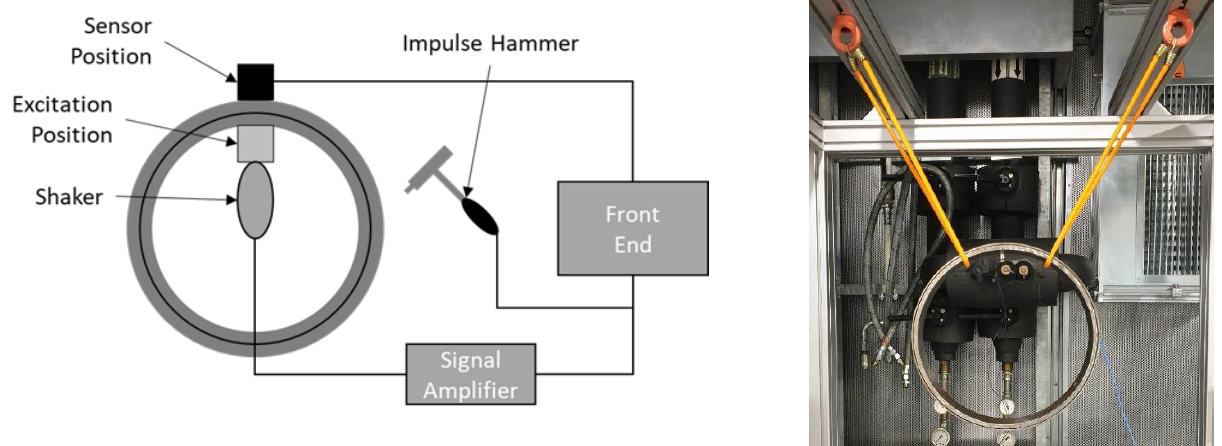
Figure 3. Measurement chain of the measurements of the freely suspended test setup ( left ) and the freely suspended test setup ( right ).